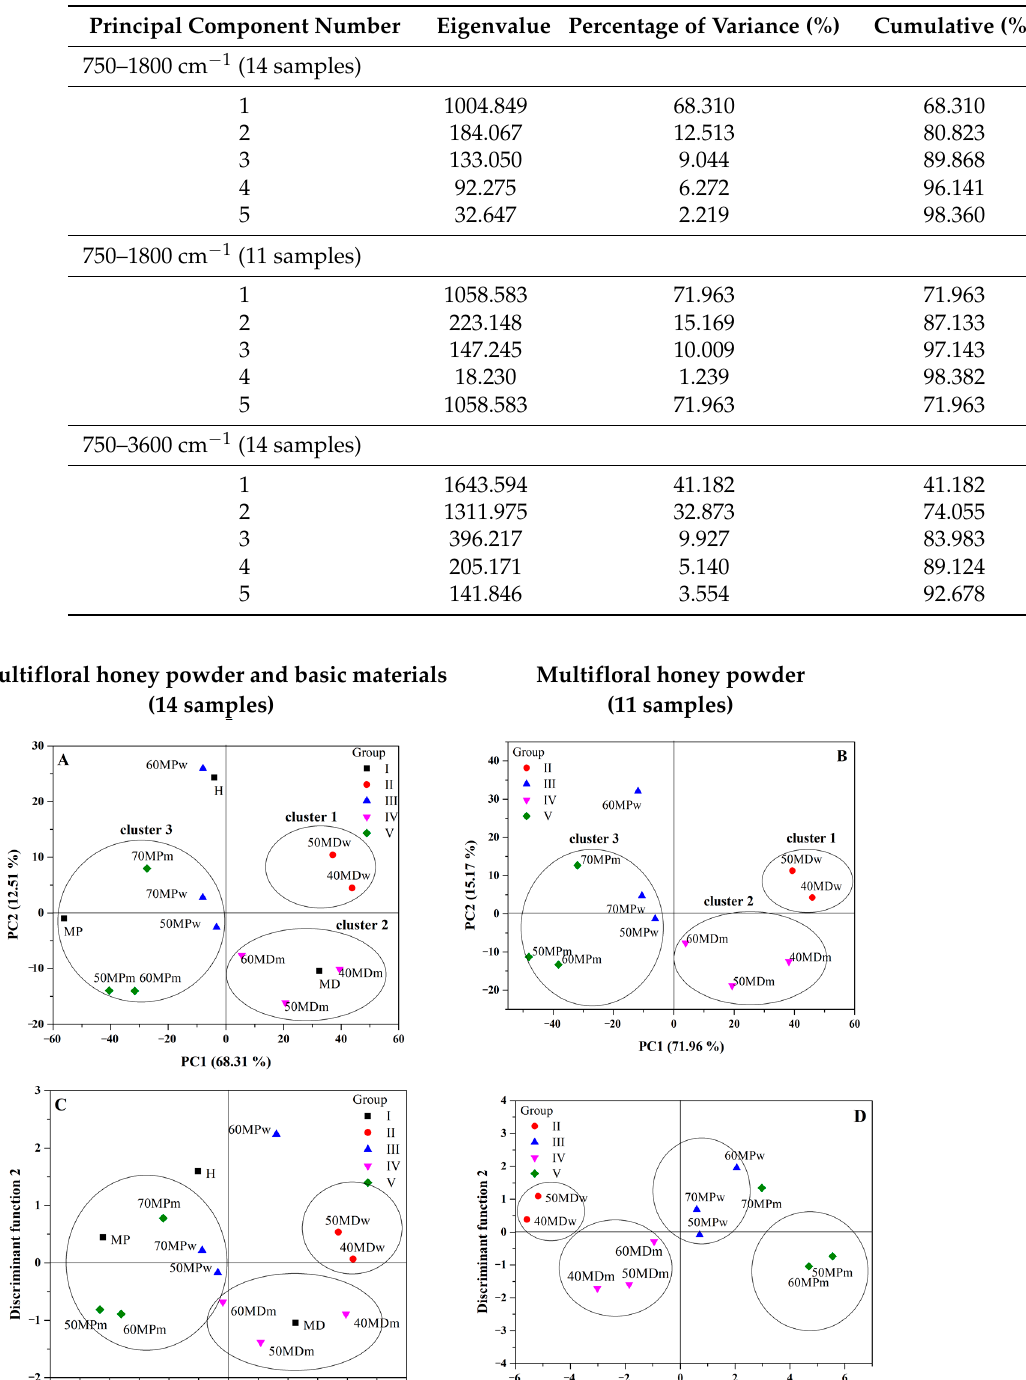
Table 3. Eigenvalues, percentage of variance, and cumulative percentage in the data used for the PCA calculations obtained for the multifloral honey, maltodextrin, and skim milk powder.